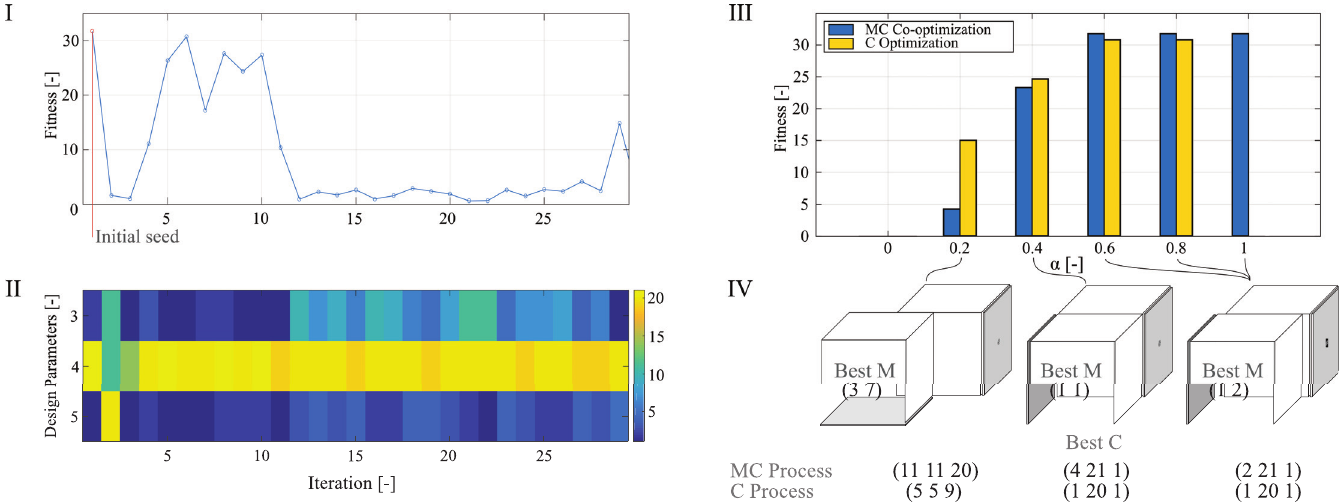
Fig 3. Bootstrapping C processesfrom MC. (I) The C optimizationuses the best MC case as initial seed and tries to further improveit. (II) As observed with the MC optimization, the designparametersare initiallyexploredto be later exploiteduntil no further improvement is seen, eventually returningto landscapeexploration.(III) The behaviorof non-optimal morphologies, observed at ɑ = 0.2 and ɑ = 0.4, are further improvedwith the C optimization, while the last morphologyfound at ɑ = 0.6 and afterwards could not have its behavior further improved by C methods. (IV) The best control parameters observed at the end of MC and C processesreveal that small morphological changes,as observedbetween(1 1) and (1 2), can strongly influence the behavior, even if the control remains unchanged, i.e. (1 20 1).